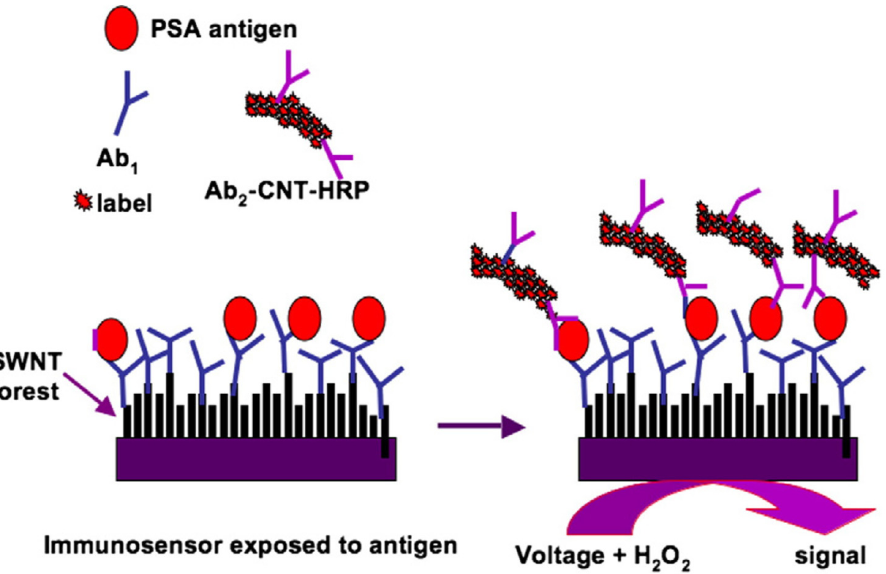
Figure 1. The typical fabrication strategy of bioelectronic immunosensors with carbon nanomateri- als [41]. Copyright 2009,